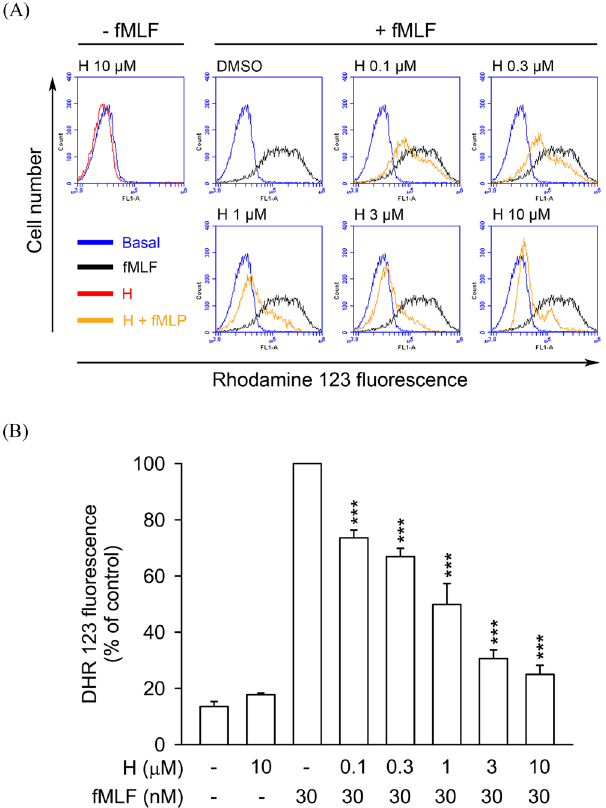
Figure 2. Honokiol inhibits ROS formation in fMLF-stimulated human neutrophils. Human neutrophils were labelled with DHR 123 (2 μ M) and incubated with 0.1% DMSO (as control) or honokiol (H; 0.1–10 μ M) for 5 min. Cells were activated using fMLF (30 nM) in the presence of CB (0.5 μ g/ml) for a further 5 min. ( A ) Representative histograms showing typical fluorescent-activated cell sorting profiles for rhodamine 123 in unstimulated cells and in cells stimulated with fMLF in the absence or presence of honokiol at the concentration indicated. ( B ) Mean fluorescence intensity is shown as the mean ± S.E.M. ( n = 5). *** P < 0.001 compared with fMLF